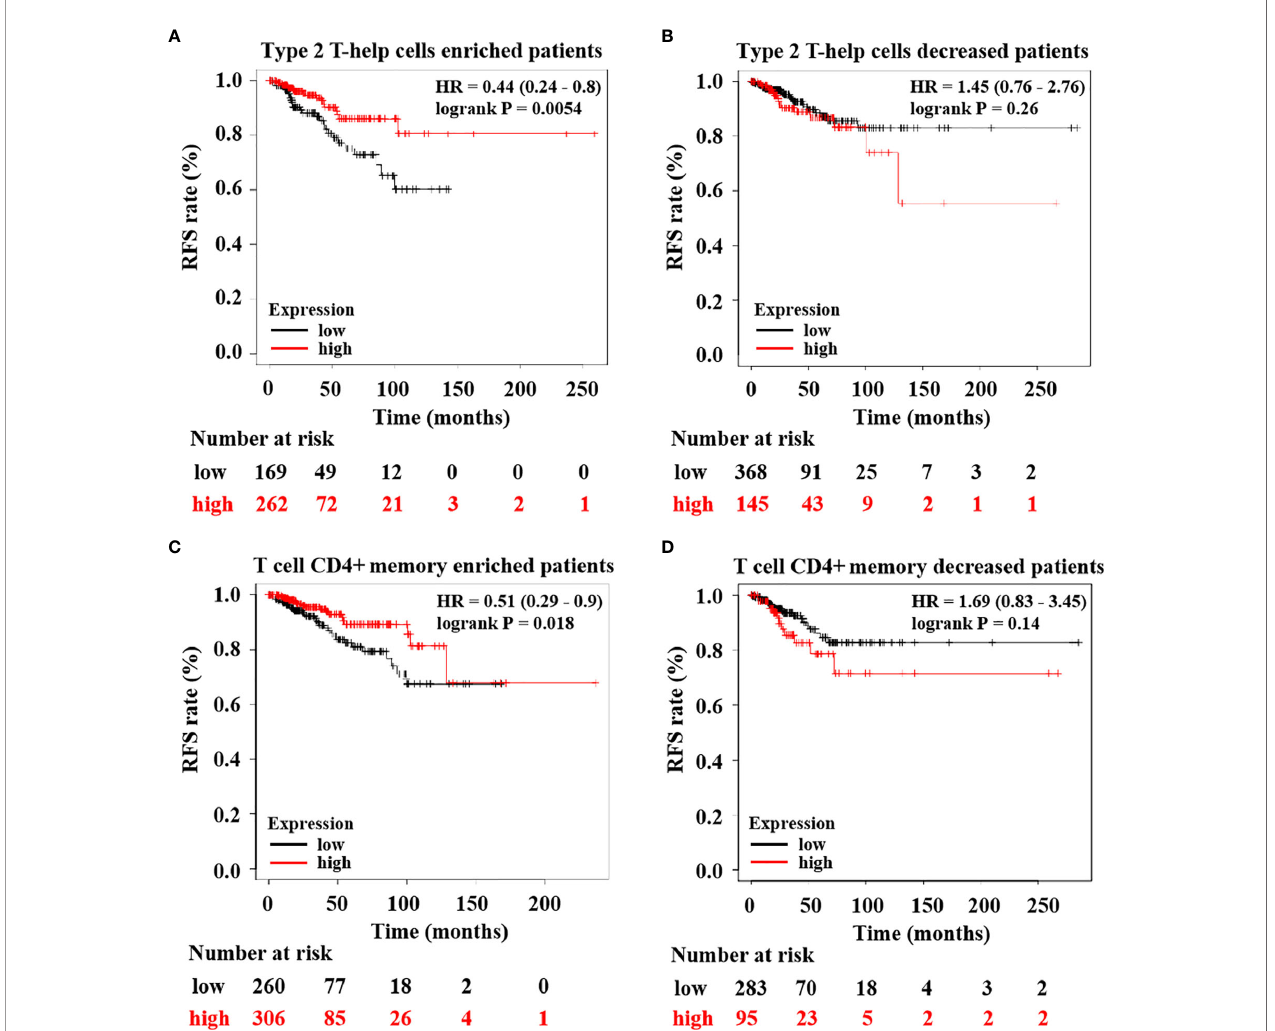
FIGURE 7 | HTR6 expression was signi fi cantly correlated with the RFS of breast cancer patients with high immune in fi ltration. HTR6 expression was correlated with the RFS of breast cancer patients with (A) enriched type 2 T-help cells, but not correlated with the RFS of breast cancer patients with (B) decreased type 2 T-help cells. HTR6 expression was correlated with the RFS of breast cancer patients with (C) enriched CD4+ memory T cells, but not correlated with the RFS of breast cancer patients with (D) decreased CD4+ memory T